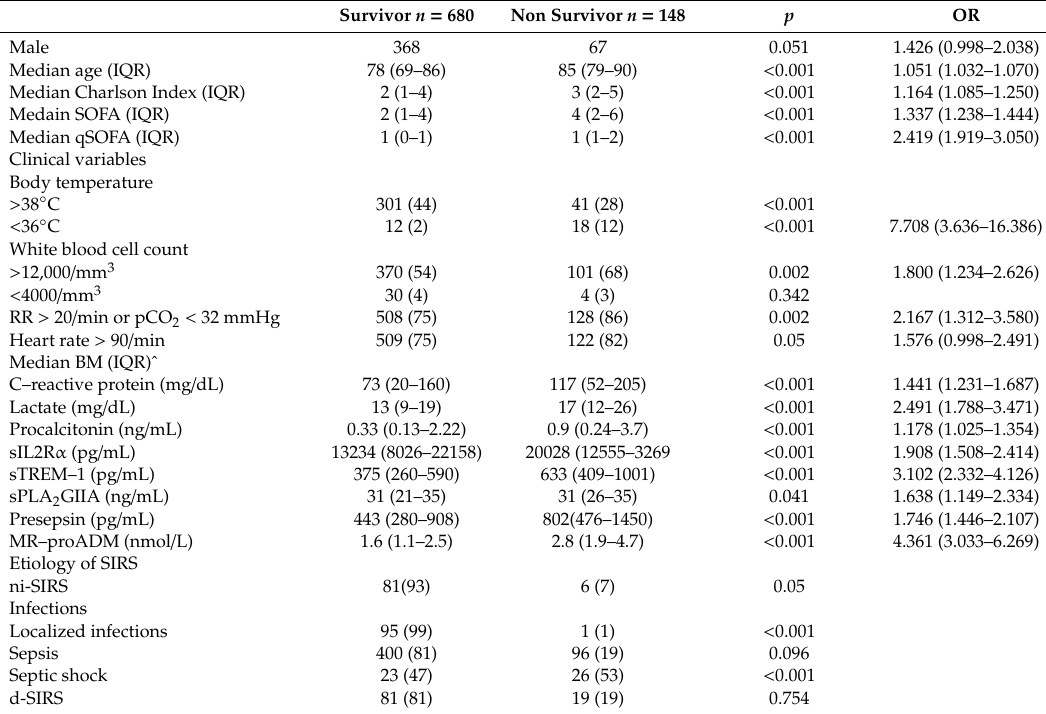
Table 1. Group 1: baseline patient characteristics and etiology of systemic inflammatory response syndrome (SIRS) at the end of the clinical